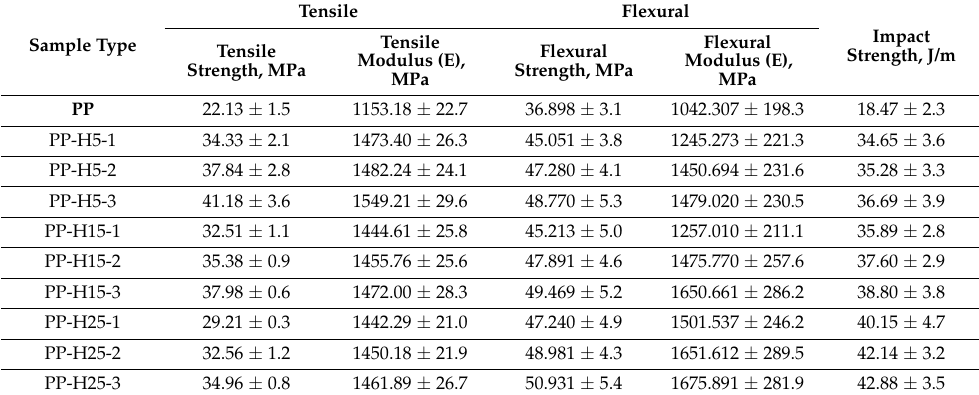
Table 3. Extracted data referring to mechanical